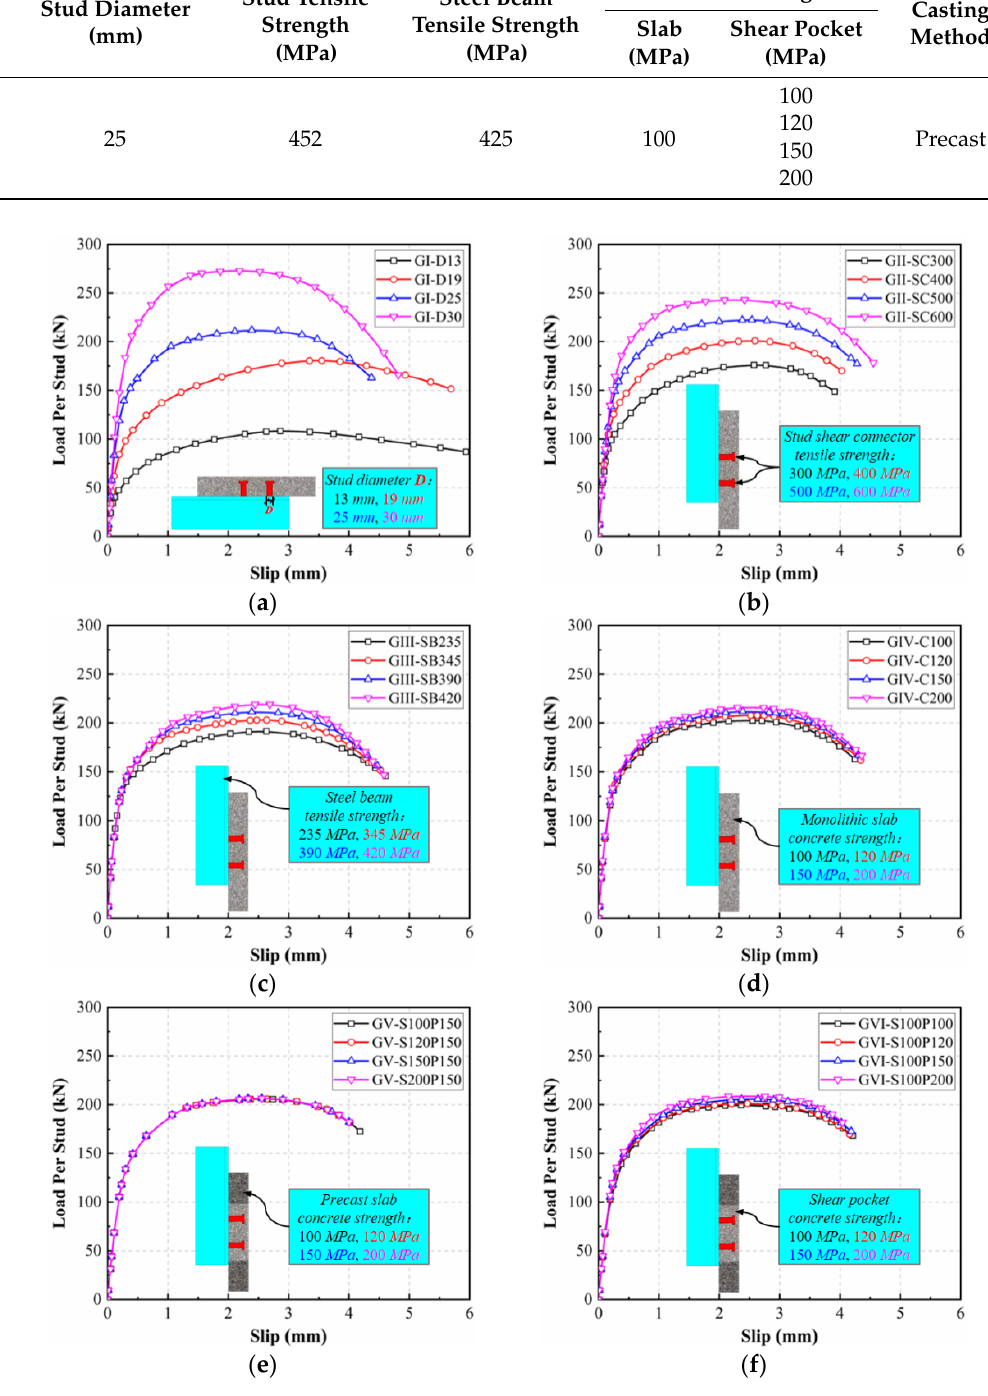
Figure 12. Load–slip relationship from parameter study: ( a ) effect of stud diameter; ( b ) effect of stud tensile strength; ( c ) effect of steel beam tensile strength; ( d ) effect of monolithic slab concrete strength; ( e ) effect of precast slab concrete strength; ( f ) effect of shear pocket concrete strength.